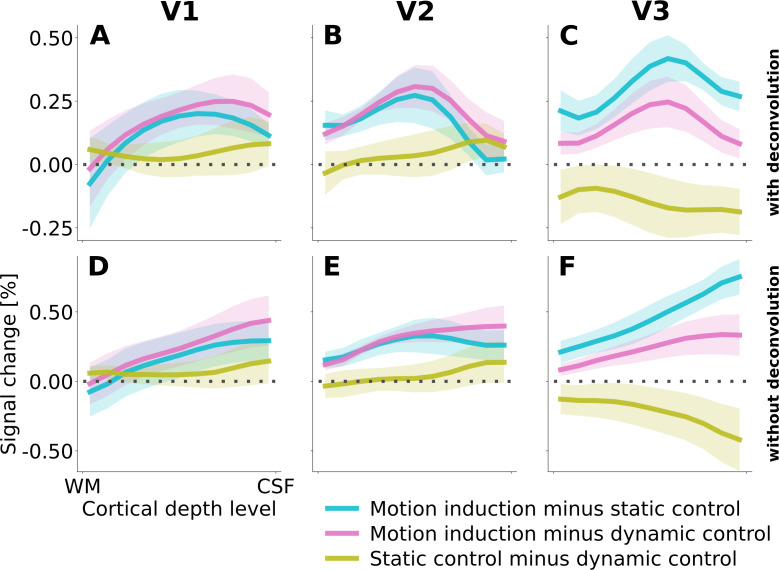
Cortical depth profiles of all three condition contrasts, with (A, B, C) and without (D, E, F) spatial deconvolution for removal of signal spread due to draining veins.There are three possible condition contrasts: motion induction vs. static control (blue line), motion induction vs. dynamic control (magenta line), and static control vs. dynamic control (yellow line). Shading represents the standard error of the mean (across subjects).